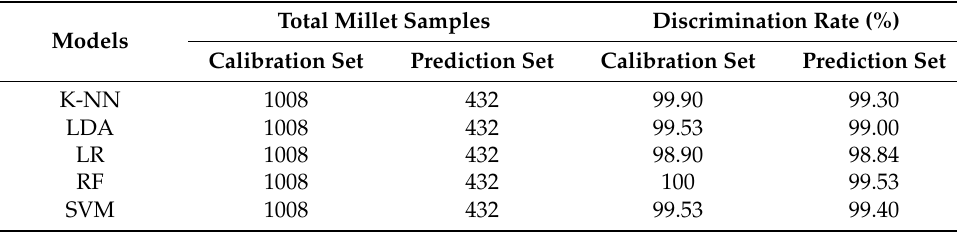
Table 3. The overall performance of the multivariate classification methods.